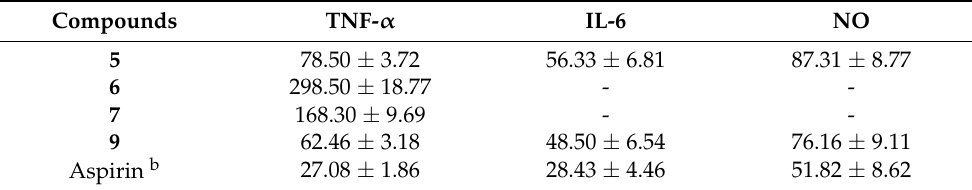
Figure 5. Effects of compounds 5 and 9 on IL-6 ( A ) and NO ( B ) production in LPS-stimulated raw 264.7 cells. ** p < 0.01, and *** p < 0.001 compared with LPS-stimulated group. Aspirin (positive control). Table 2. IC 50 values a ( µ M) of compounds 5 – 7 and 9 as inhibitors of TNF- α , IL-6 and NO.